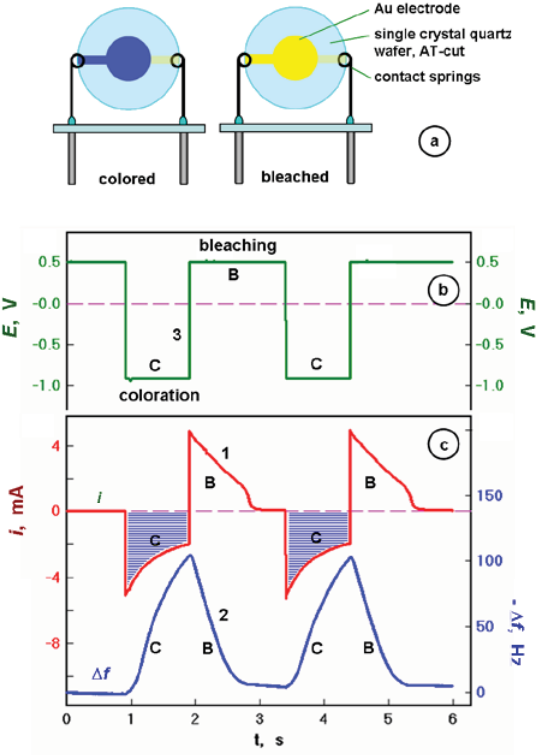
Figure 1. (a) Colored and bleached WO films electrodeposited 3-x on a quartz crystal piezoresonator; (b) potential program of double-pulse experiments; (c) current (1) and resonant frequency shift (2) responses to potential